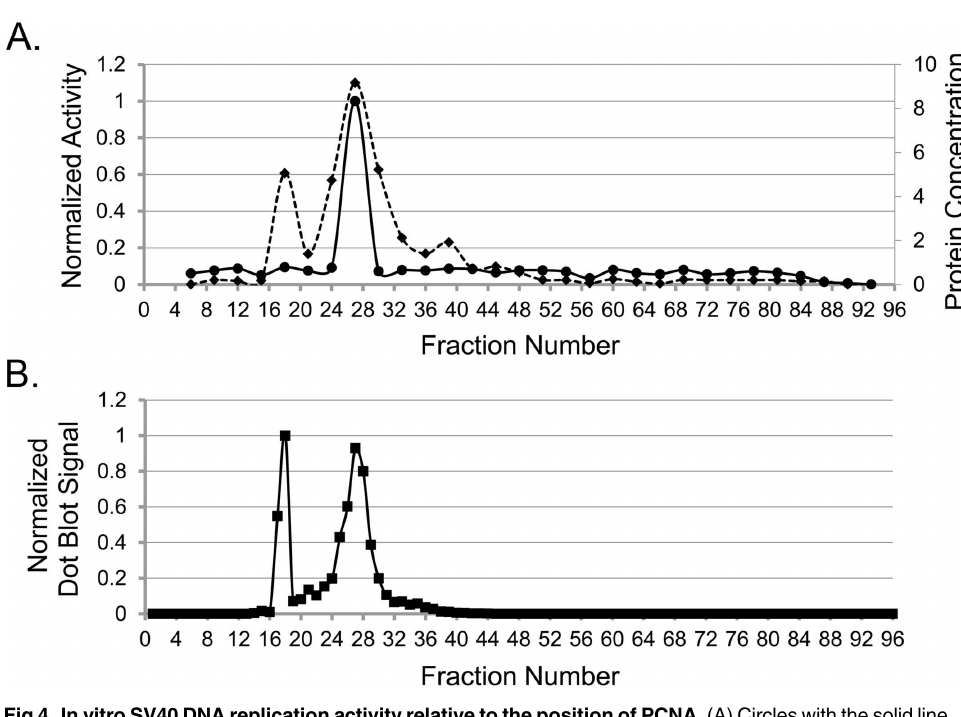
Fig 4. In vitro SV40 DNA replication activity relative to the position of PCNA. (A) Circles with the solid line represent the normalizedSV40 DNA replication activity labeledon the left axis. Diamondswith the dotted line represent the protein concentration in μ g labeledon the right axis. (B) Squaresrepresent dot blot quantification of PCNA levels from IZE fractions run on the same day. The data were normalized